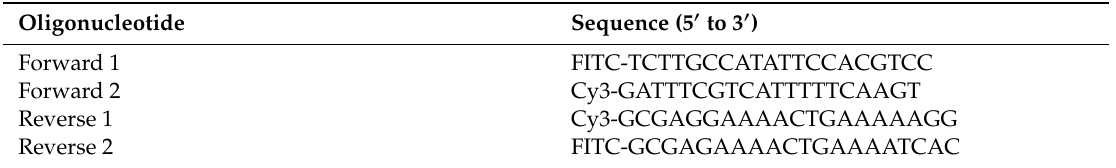
Table 2. RNA FISH